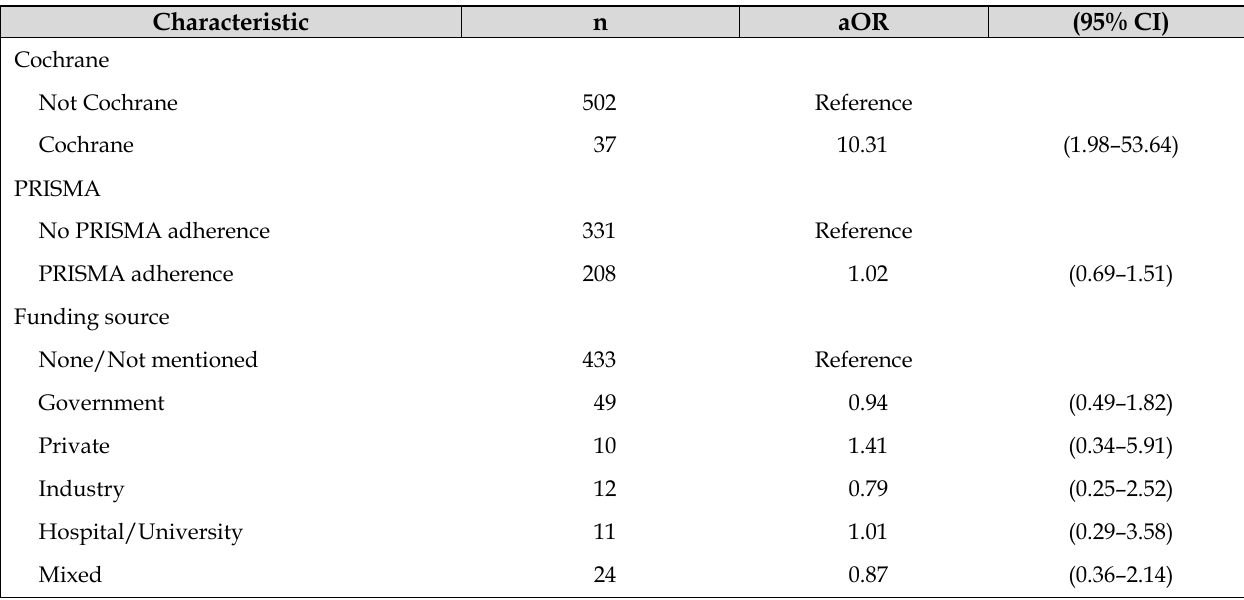
Table 1 Penalized logistic regression of trial characteristics and use of hand-searching reference lists